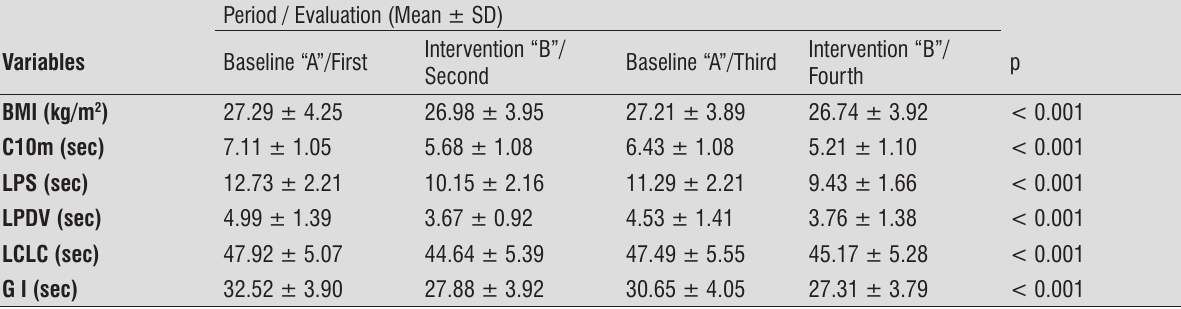
Table 3 - Comparison of body composition results and functionality tests (GDLAM) of older adults after intervention and baseline periods (n =